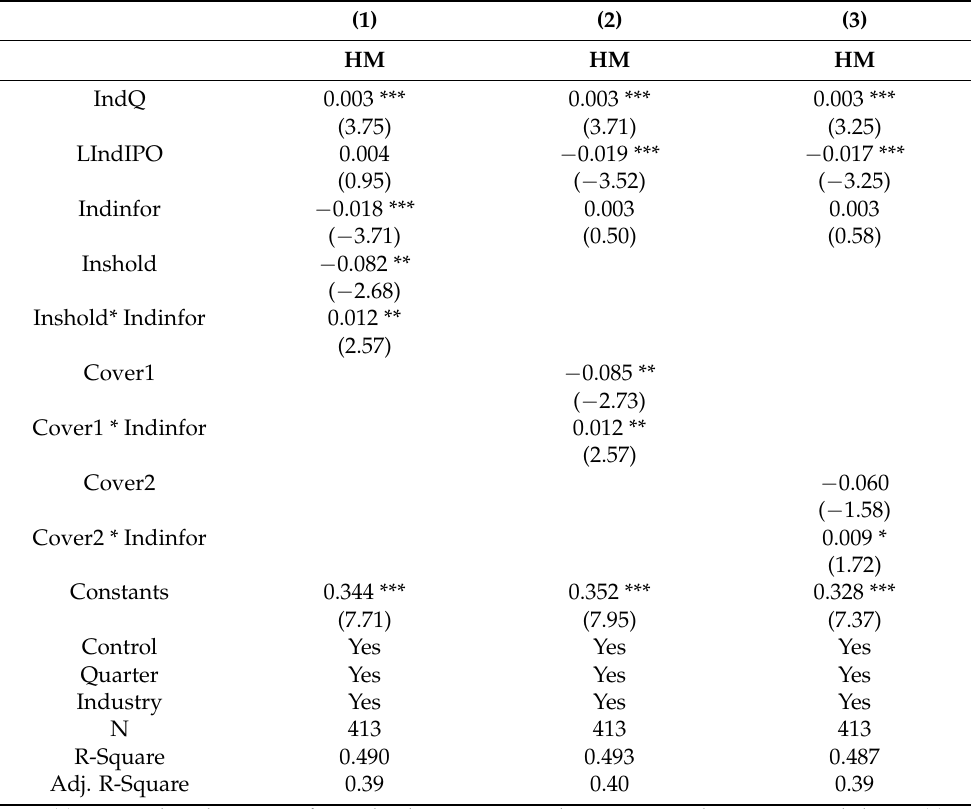
Table 5. Herding under a different external information